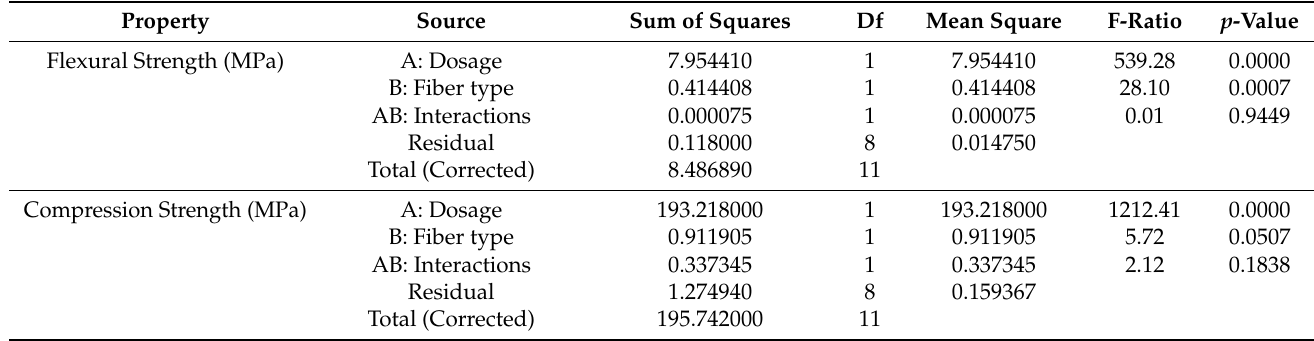
Table 7. Analysis of variance (ANOVA) for flexural and compressive strength.